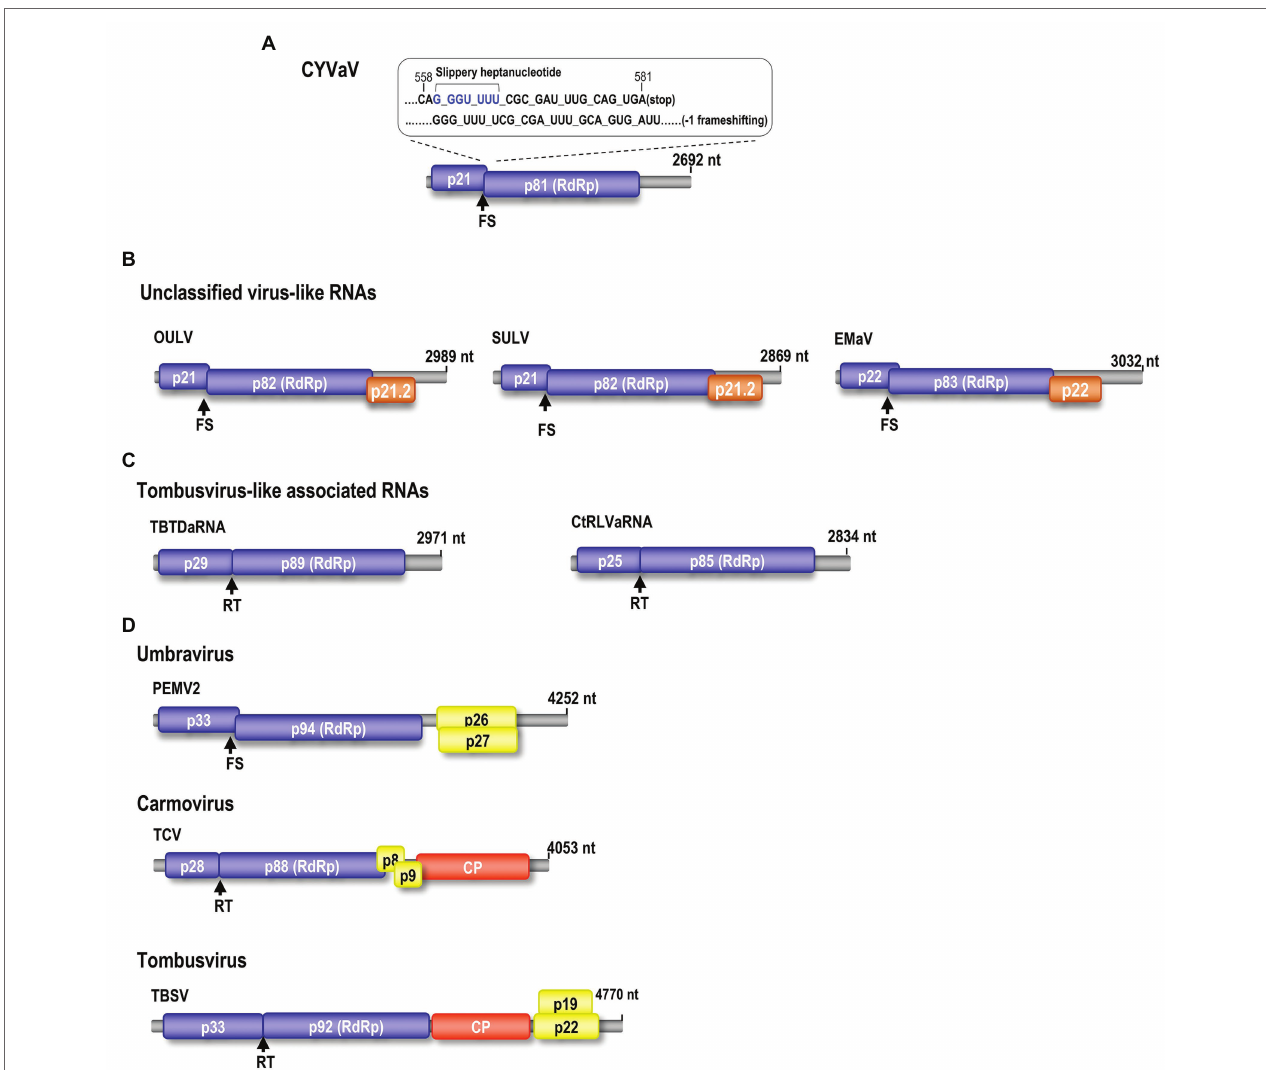
FIGURE 2 | Genomic organization of CYVaV. The CYVaV genome contains two open reading frames (ORFs): ORF1 (replication-required protein, nt 9–581, 21.5 kDa), ORF2 (RNA-dependent RNA polymerase, RdRp, nt 9–2,191, 81 kDa). ORF2 is predicted to be expressed by − 1 frame shifting at nucleotide position 561 (A) . Comparison of gene organization of selected viruses and virus-associated RNAs in the Tombusviridae : Unclassified virus-like RNAs; opuntia umbra-like virus (OULV), sugarcane umbra-like virus (SULV), and Ethiopia maize-associated virus (EMaV; B ). Tombusvirus-like associated RNAs; tobacco bushy top disease- associated RNA (TBTDaRNA), carrot red leaf virus associated RNA (CtRLVaRNA; C ). Umbravirus; PEMV2. Carmovirus; turnip crinkle virus (TCV). Tombusvirus; tomato bushy stunt virus (TBSV; D ). FS, − 1 ribosome frameshift recoding. RT, readthrough ribosome